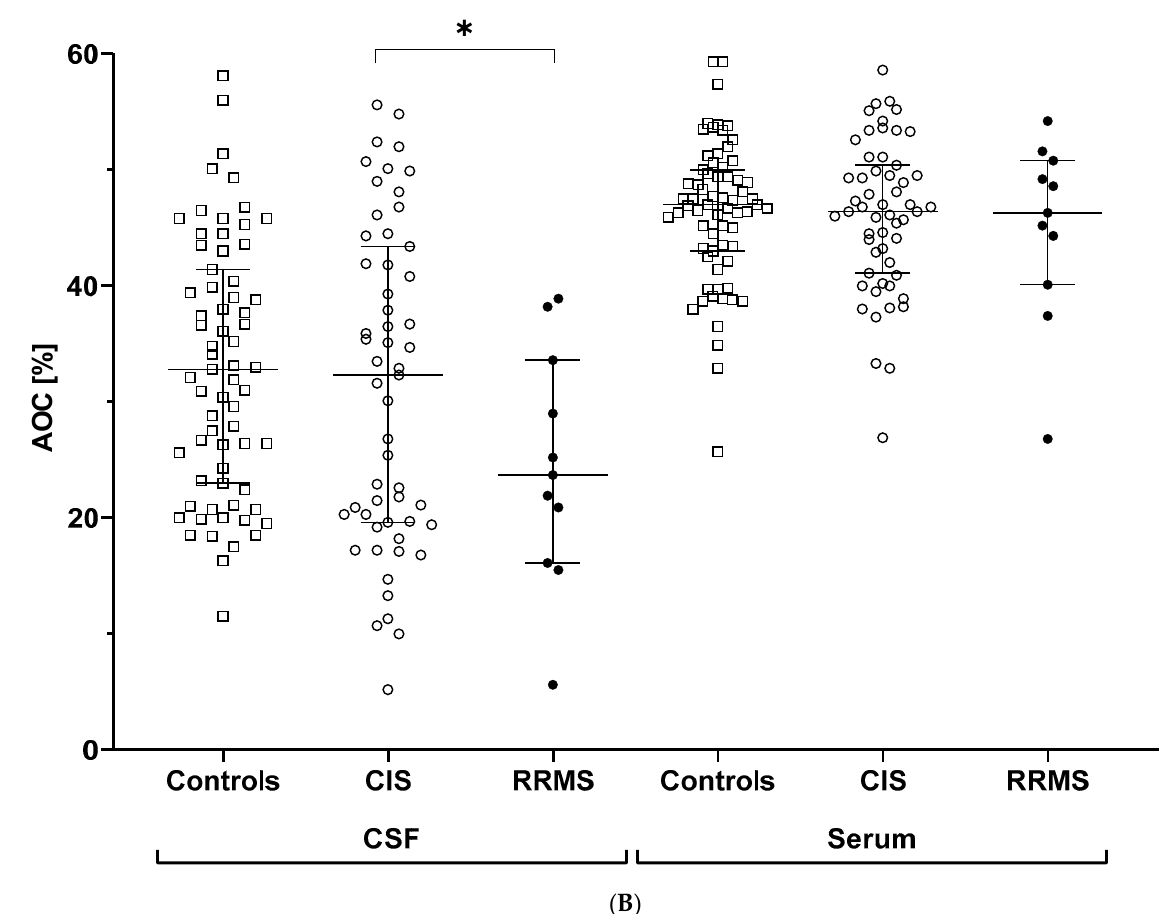
Figure 1. AOC in serum and CSF and its relation to disease course in MS. AOC values in serum and CSF in CIS and RRMS patients and controls. ( A ) CSF and serum AOC correlated mutually in both patients and controls (both r = 0.45, p < 0.001). ( B ) CSF AOC was significantly different between CIS and RRMS patients and controls ( p = 0.031; adjusted for covariates) and showed lower values in RRMS compared to CIS patients ( p = 0.020). Serum AOC was similar for CIS and RRMS patients and controls. AOC = antioxidative capacity; CIS = clinically isolated syndrome; CSF = cerebrospinal fluid; RRMS = relapsing-remitting multiple sclerosis. Horizontal lines represent median values. Significance ( p < 0.05) was assessed between subgroups by univariate general linear model and Bonferroni post-hoc test. * p < 0.05.